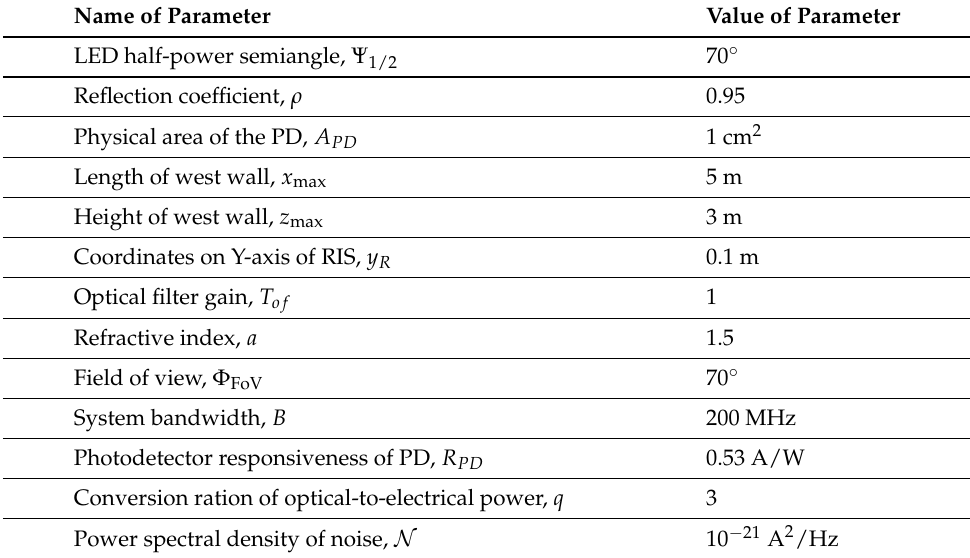
Table 1. Main simulation